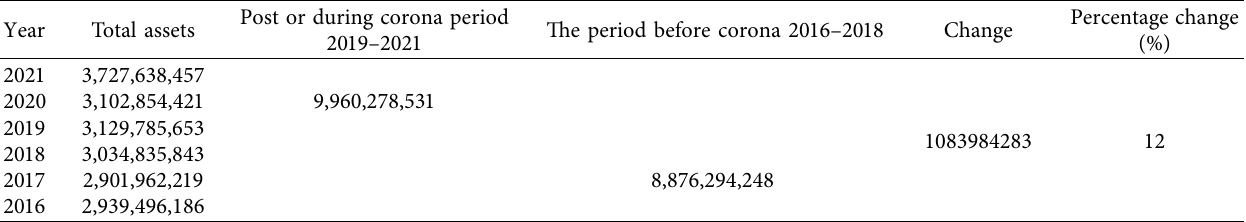
Table 1: Te development of the total assets of the study sample companies before and after the application of the standard. Year Total assets